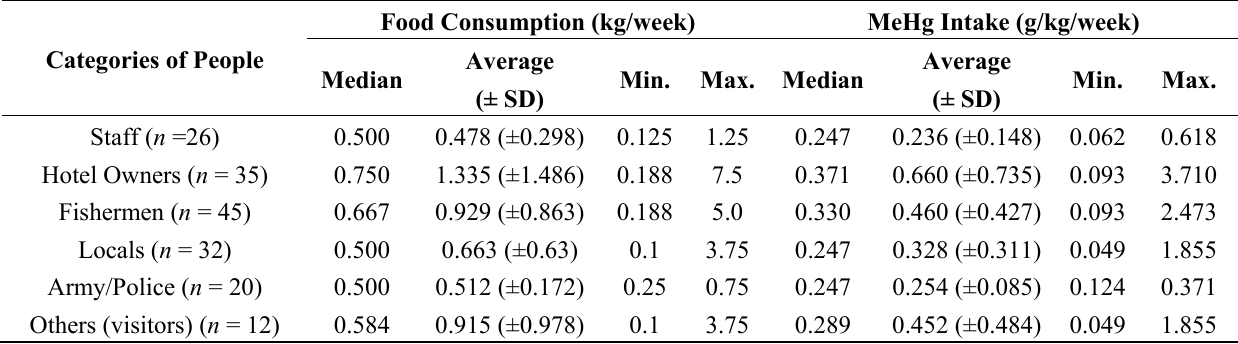
Table 1. Fish consumption (kg/week) and MeHg intake (µg/kg/week) from Lake Phewa by different categories of people ( n = 170).